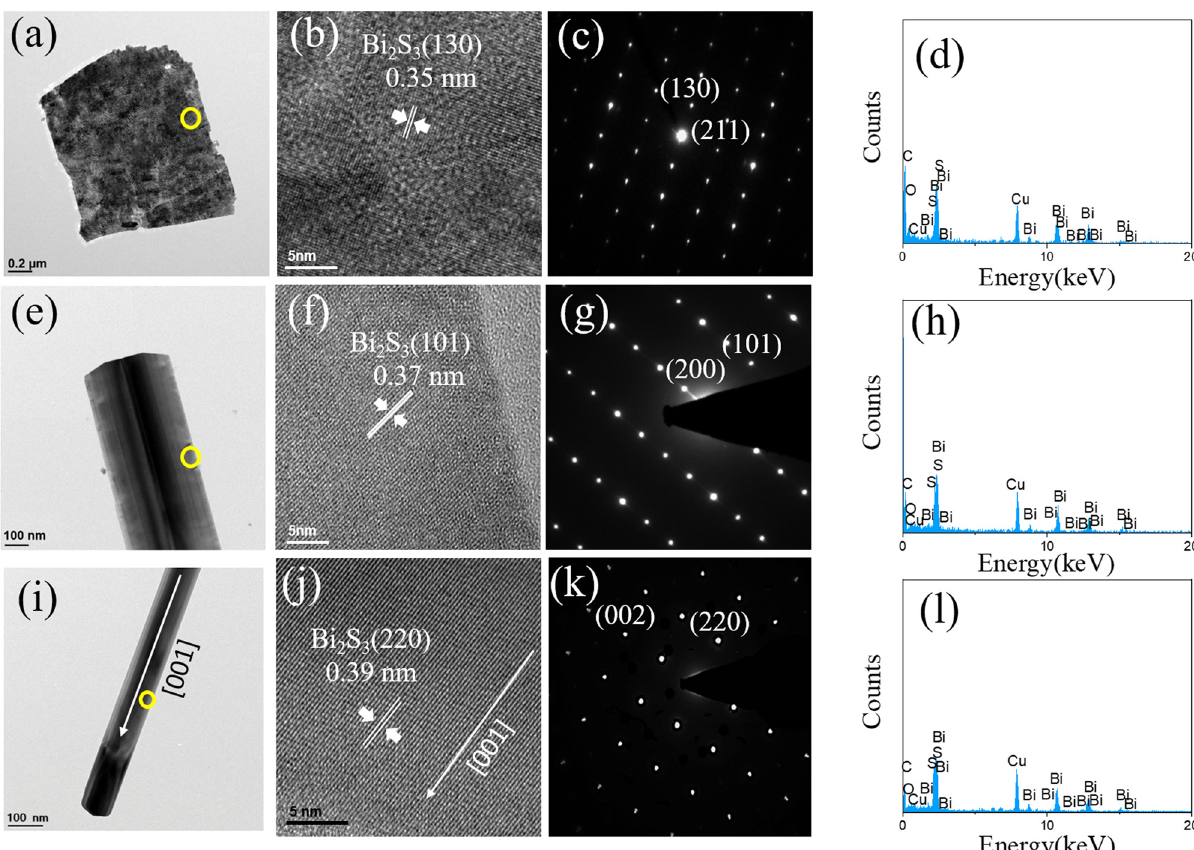
Figure 3: ( a ) Low - magni fi cation TEM image of the Bi 2 S 3 nanosheet. ( b ) HRTEM image of the Bi 2 S 3 nanosheet taken from the local region.